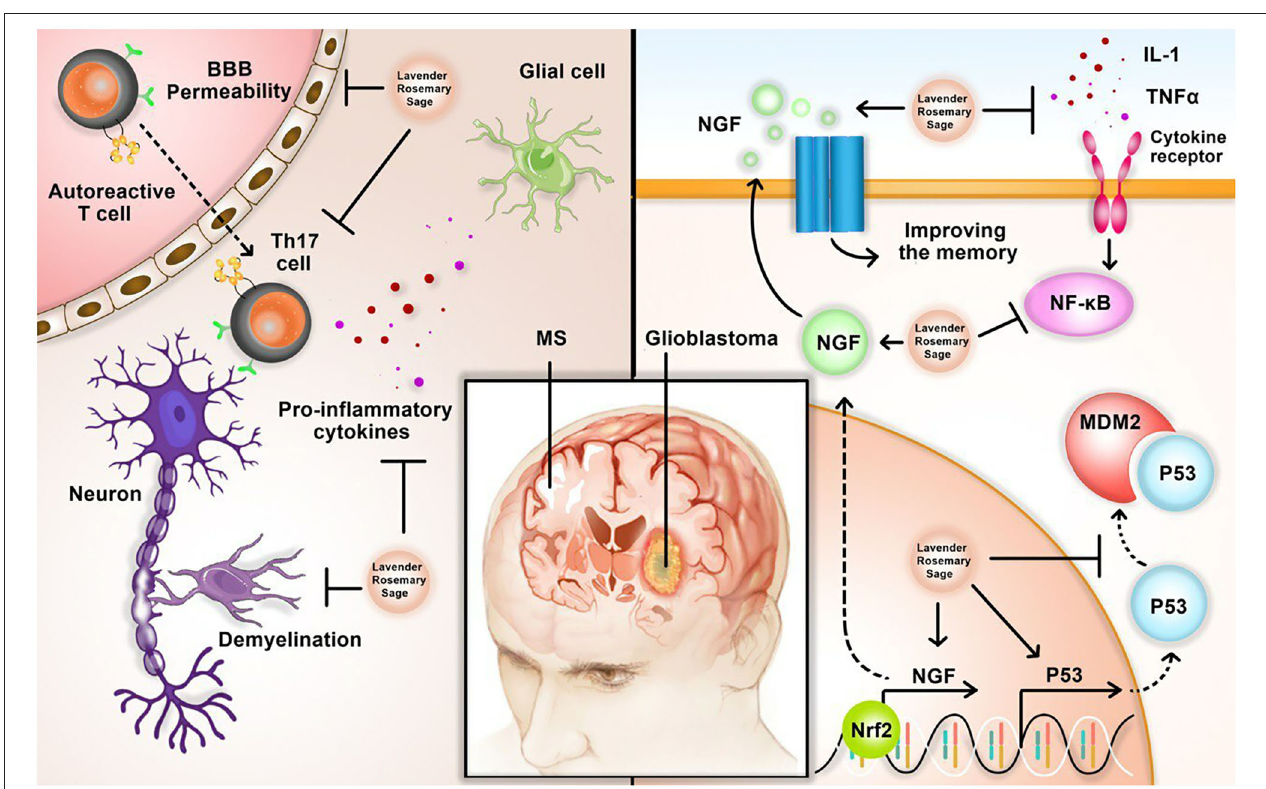
Figure 2 | Neuroprotective effects of sage, lavender, and rosemary in Multiple sclerosis (MS) and glioblastoma. In MS, herbal medicine can inhibit Blood-Brain Barrier (BBB) permeability, T helper 17 (Th17) polarization, pro-inflammatory cytokines secretion, and axonal demyelination. In glioblastoma, herbal medicine can induce transcription of p53 and NGF, resulting in memory improvement. Sage, lavender, and rosemary can also inhibit nuclear factor κ B (NF- κ B), pro-inflammatory cytokines, and MDM2, which is an inhibitor of tumor suppressor